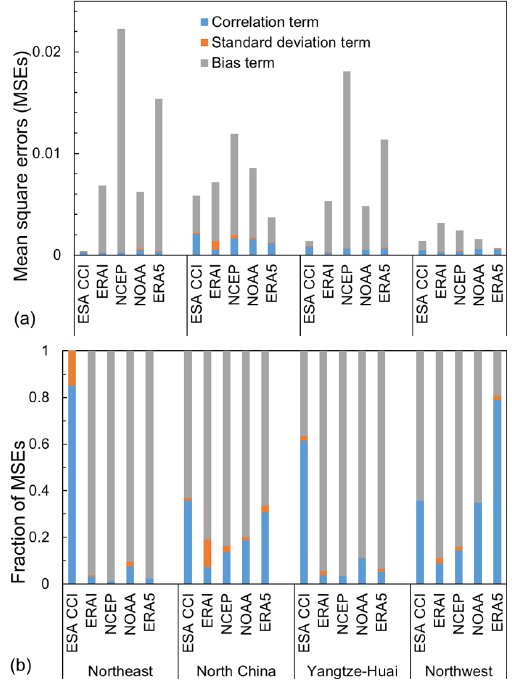
Figure 9. The (a) decomposition of three terms to the mean square errors (MSEs) for the four satellite and reanalysis products from 1981 to 2013 and (b) their